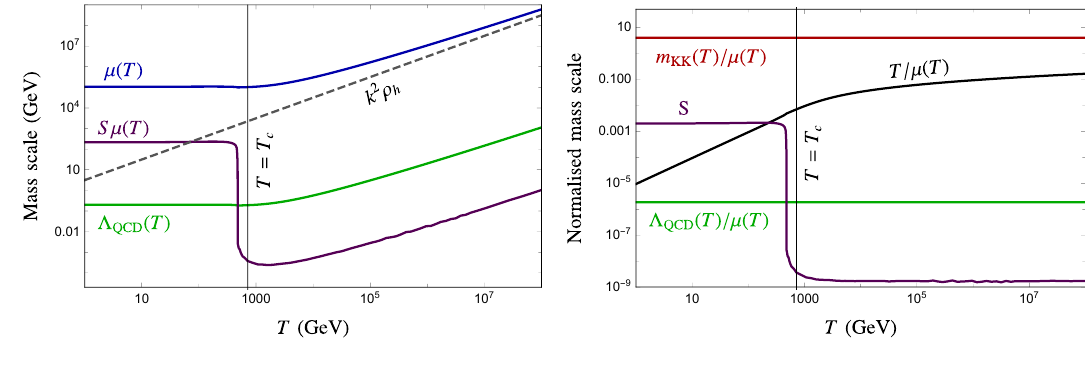
Figure 2 . Plots showing the dependence of mass scales in the theory with temperature, for param- eters in equation (3.22). The left plot shows the radion expectation value ( µ ), the scalar expectation value ( Sµ ) and the QCD scale, while the second plot shows the same quantities and the KK scale with the dependence on the radion factored out. The vertical line shows the critical temperature T c ∼ 700 GeV . The dashed black line in the first plot shows the horizon location k 2 ρ h as a function of